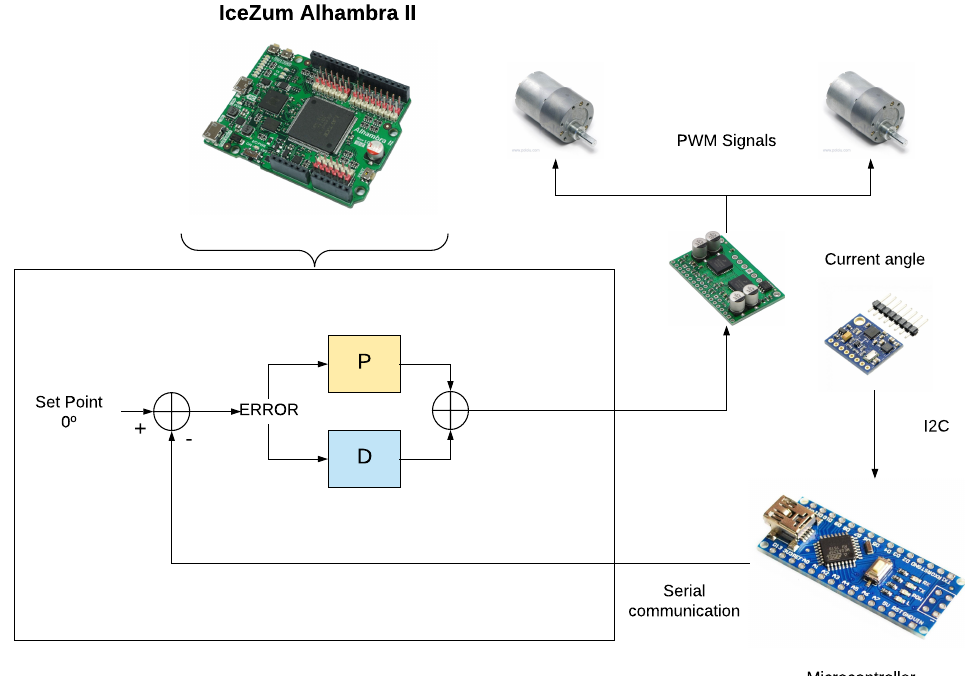
Figure 3. Hardware design of the inverted pendulum control with FPGA